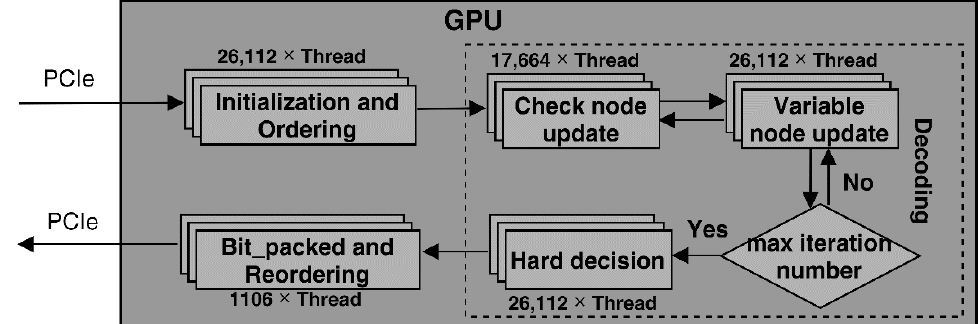
Figure 1. Process flow of the proposed GPU-based LDPC decoder without the evaluate check part.